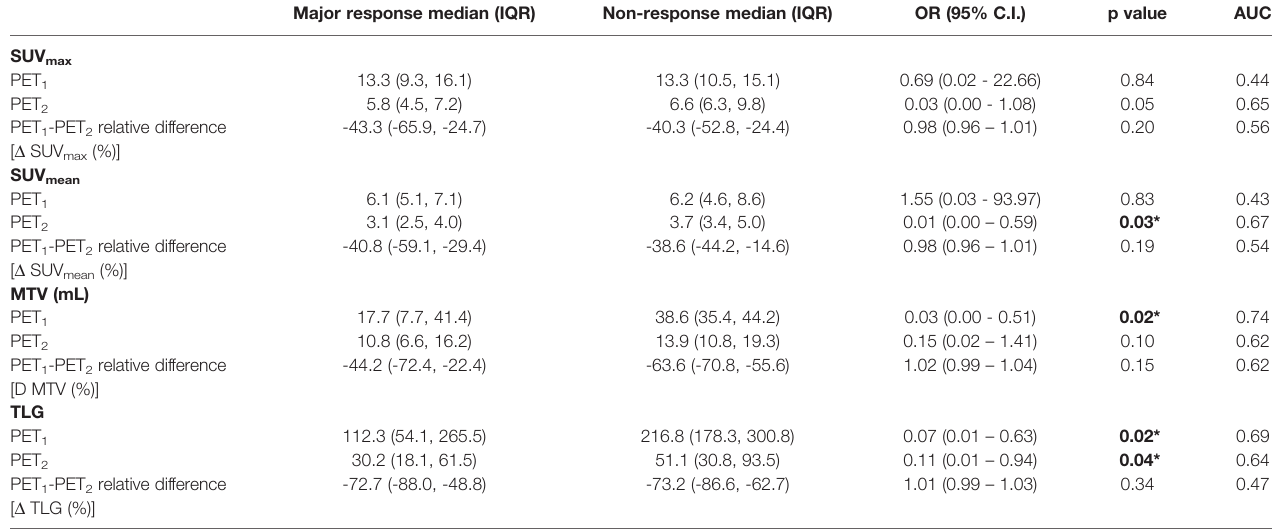
TABLE 2 | Results of the logistic regression and ROC curve analysis of metabolic 18F-FDG parameters before and after induction chemotherapy, with their relative differences.